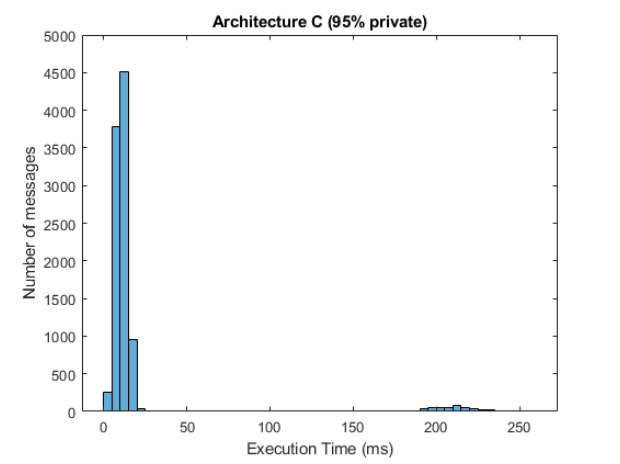
Figure 11. Histogram for architecture C (95% private messages).